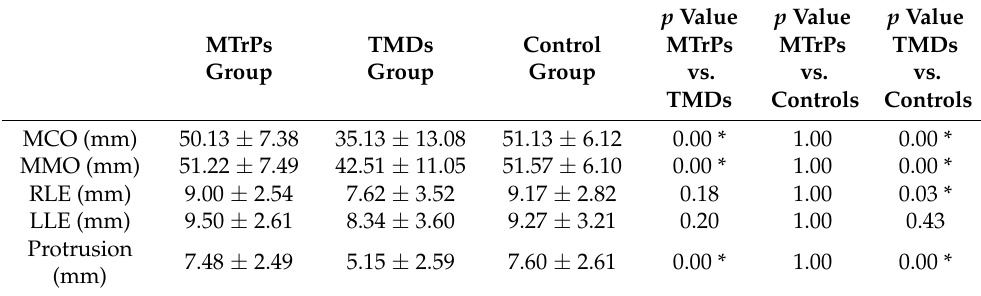
Table 2. Comparison of the mean values ( ± SD) of mandibular range of motion during maximum comfortable pain-free opening (MCO), maximum mouth opening (MMO), right lateral excursion (RLE), left lateral excursion (LLE) and protrusion between